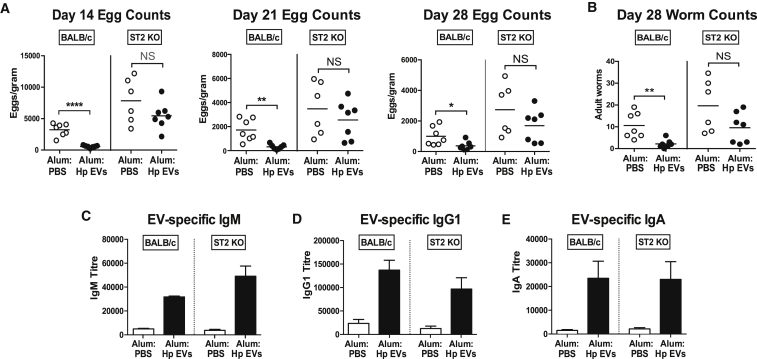
Vaccination against EVs Is Poorly Protective in H. polygyrus-Susceptible ST2-Deficient Mice(A) Female T1/ST2−/− and BALB/c mice were vaccinated with EVs or PBS in alum adjuvant prior to challenge with 200 H. polygyrus L3 larvae (as Figure 5A), and eggs counts per gram fecal matter were enumerated on days 14, 21, and 28 post-infection.(B) Intestinal adult worm burdens were measured on day 28.(C–E) EV-specific titers of (C) IgM, (D) IgG1, and (E) IgA detectable from sera of EV- or PBS-immunized mice measured by ELISA. (A–E) Data are pooled from two independent experiments (n = 6–7), presented as mean values ± SD (Student’s t test, ∗p < 0.05, ∗∗p < 0.01, and ∗∗∗∗p < 0.0001; NS, not significant).